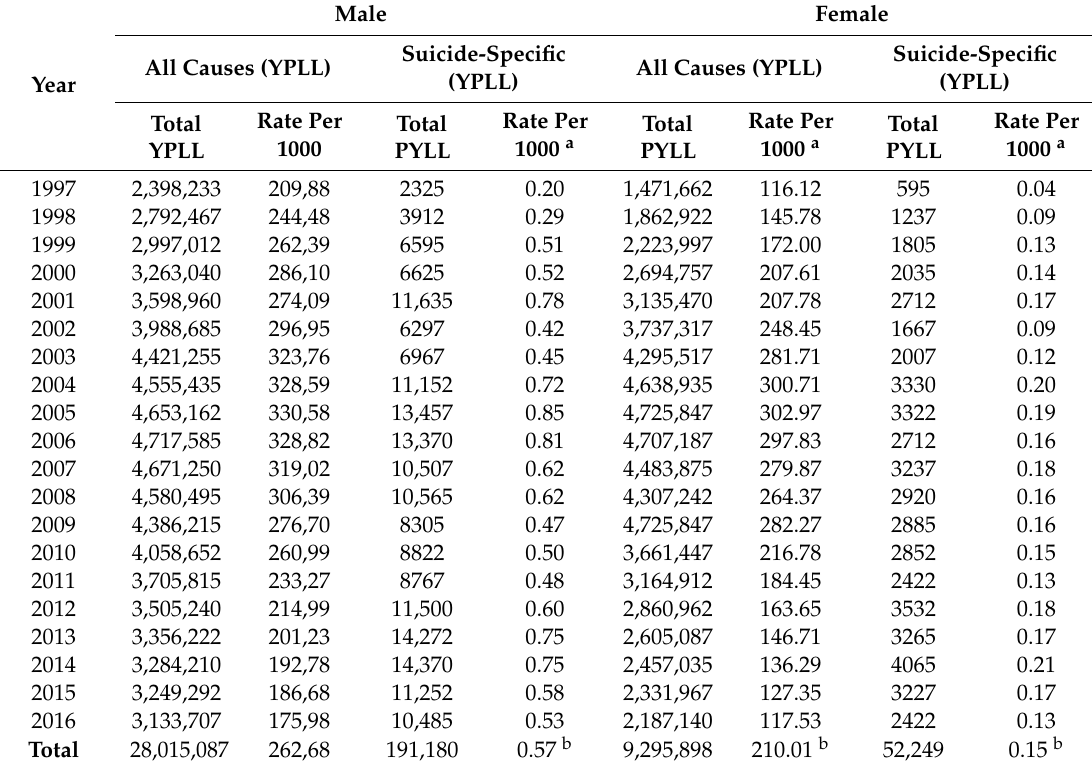
Table 3. Years of potential life lost (YPLL) estimates by all causes of death and suicide-specific cause of death by year and